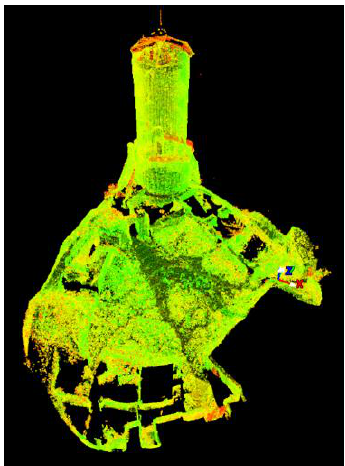
Figure 3. Result of point cloud registering and filtering